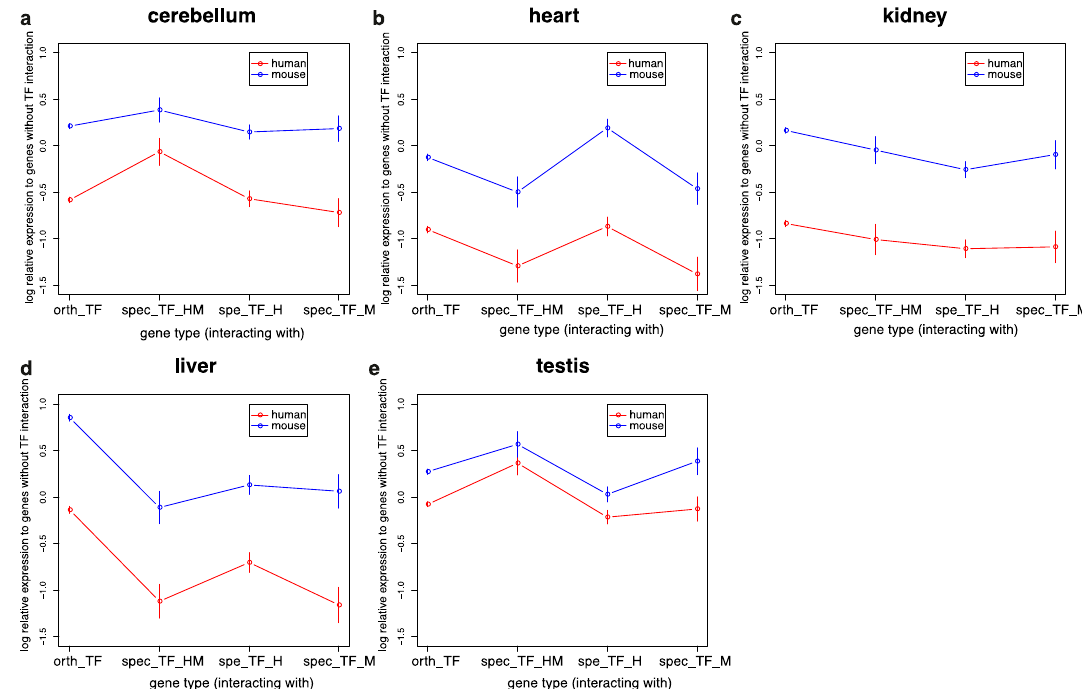
Figure 3. Log expression levels of transcription factor (TF)-interacting and non-interacting human and mouse orthologous genes. ( a )Expression of genes in cerebellum. ( b )Expression of genes in heart. ( c )Expression of genes in kidney. ( d )Expression of genes in liver. ( e )Expression of genes in testis. Standard error bars are attached to the means. Orthologous genes were divided into four groups according to their interactions with TFs, namely, those that interact with orthologous TFs (orth_TF), human- and mouse-specific TFs (spec_TF_HM), human- but not mouse-specific TFs (spec_TF_H), and mouse- but not human-specific TFs (spec_TF_M).